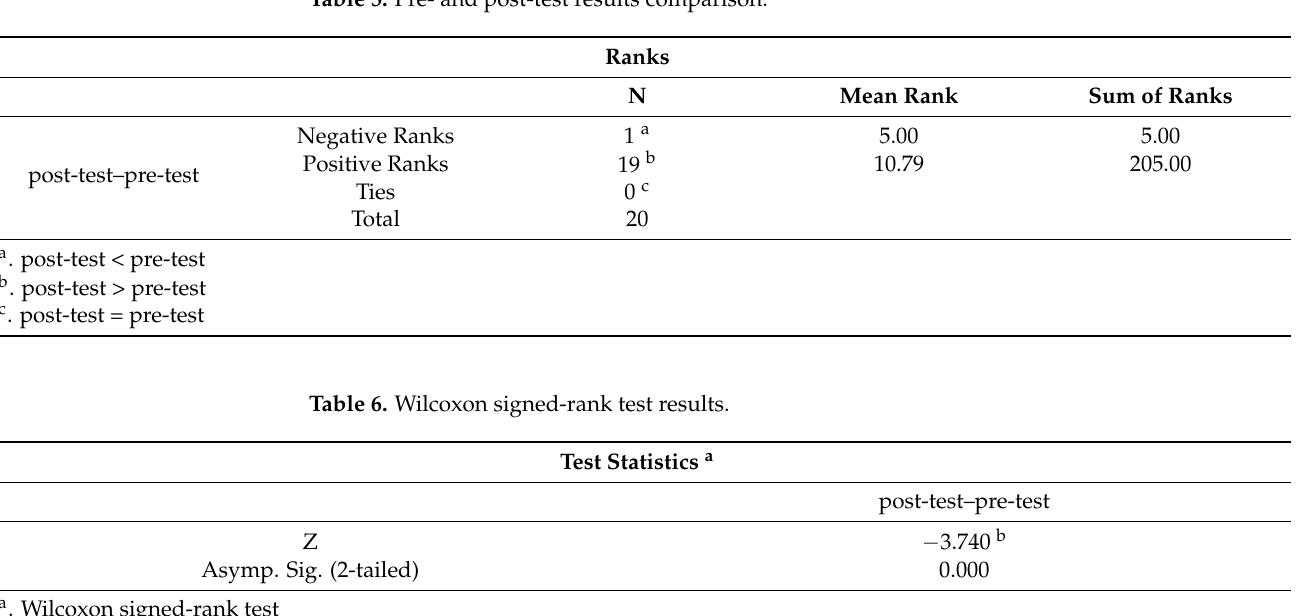
Table 5. Pre- and post-test results comparison.